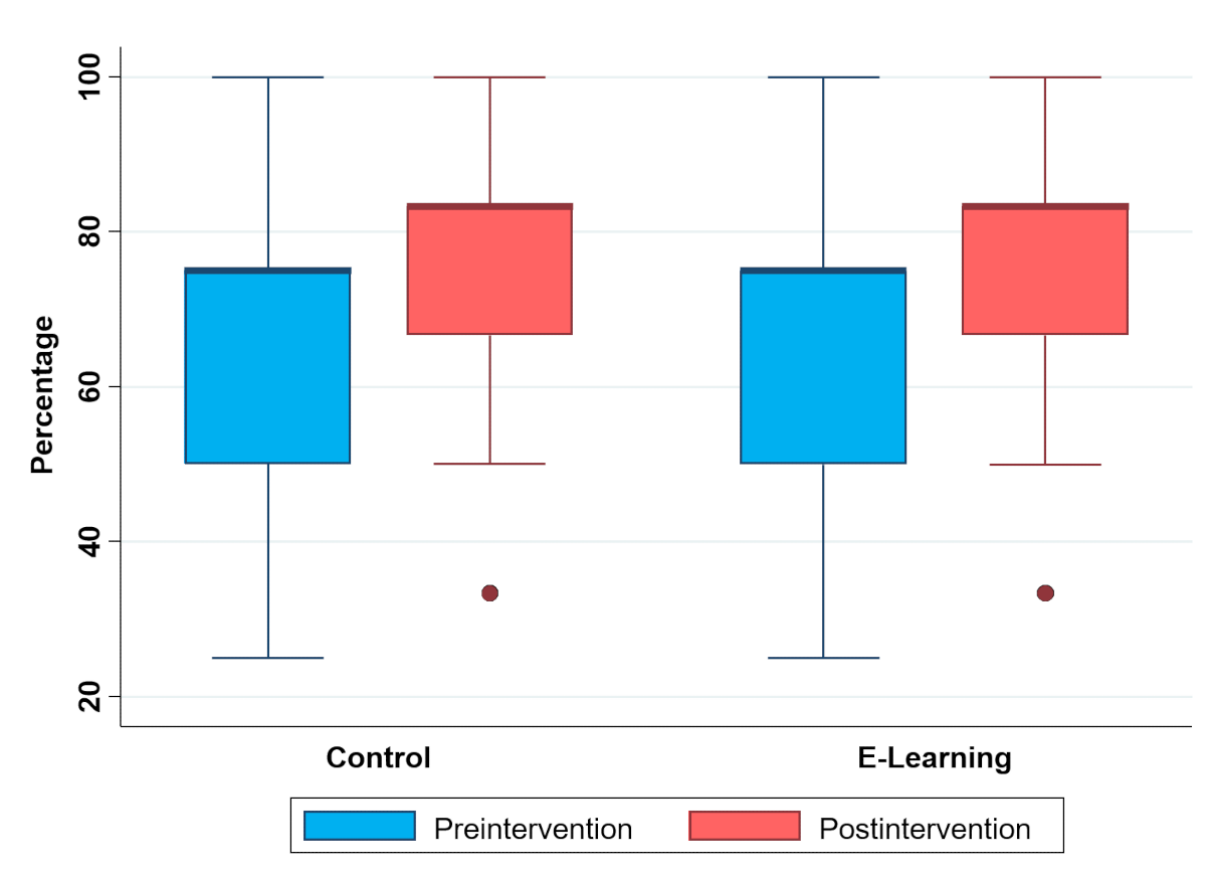
Figure 3. Change in proportion (%) of adequate choice of personal protective equipment.